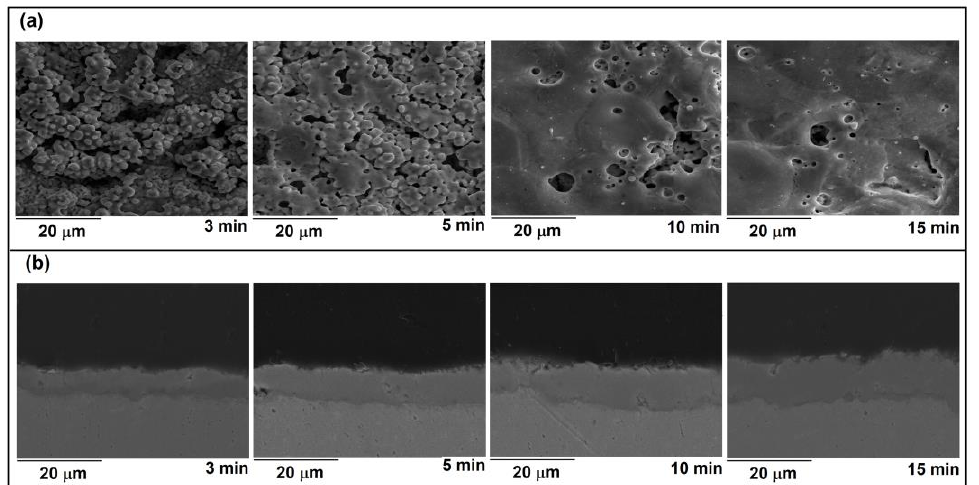
Figure 4. ( a ) Top view; ( b ) cross-section; micrographs of coatings formed at various stages of the MDs.